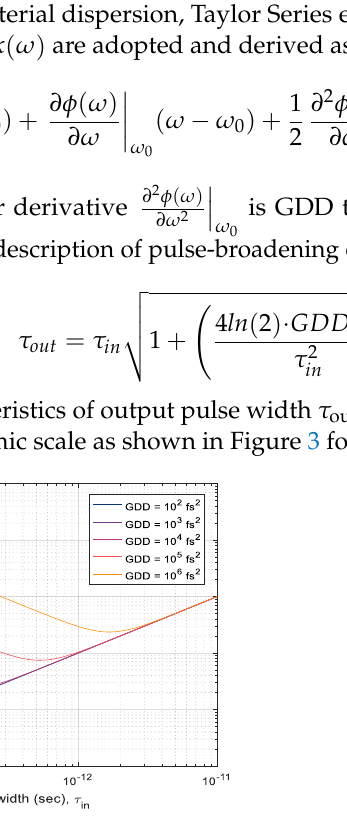
Figure 3. Plots of curves on broadened output pulse width versus input pulse width at various GDD values.